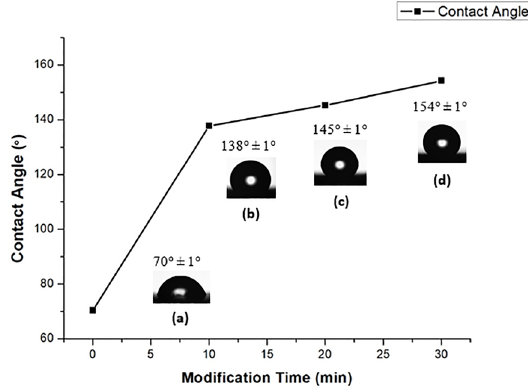
Figure 5. Images of the Drops: (a) sanded; treated with zinc nitrate and stearic acid after HCl (2M) acid etching - (b) after 10 min; (c) after 20 min and (d) after 30 min in HCl (2M).